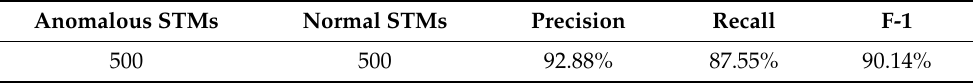
Table 3. Validation results of the proposed method by using the domain knowledge